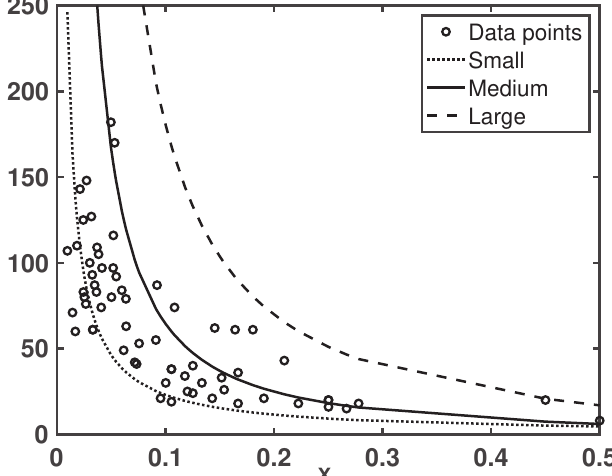
Figure 2. Colony size N as a function its reproductive ratio X . Open circles are data collected from 65 colonies. Varied curves are functions of N = φ ( X ) by letting e = 2.42, d g = 0.00028, d w = 0.0025, β g = 33, δ g = 0.99, δ n = 0.261, and β n = 35.2 (short-dashed curve shows a small-size colony as colony approaches to N ∗ = 37.94, X ∗ = 0.0732 under those values), β n = 74.6 (solid curve shows a median colony size as colony approaches to N ∗ = 60, X ∗ = 0.1114 under those values), β n = 145.2 (long-dashed curve shows a large-size colony as colony approaches to N ∗ = 90.67, X ∗ = 0.16 under those values),